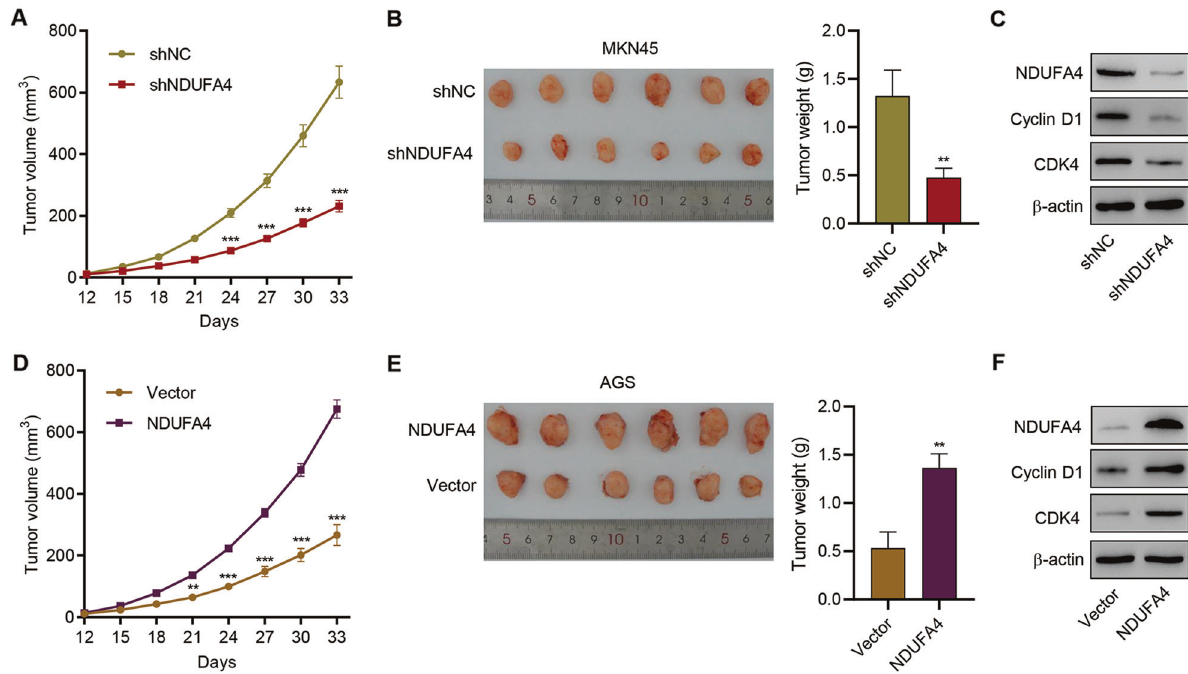
Fig. 3 NDUFA4 promoted GC growth in vivo. AGS cells transduced with shNC or NDUFA4 shRNA vector and MKN45 cells transduced with NDUFA4 expression vector were subcutaneously injected into the armpits of the nude mice, respectively. A , D Tumor volume in each group. B , E Tumor weight in each group. C , F Expression of NDUFA4, Cyclin D1 and CDK4 in each group. *** P < 0.001 vs. shNC or